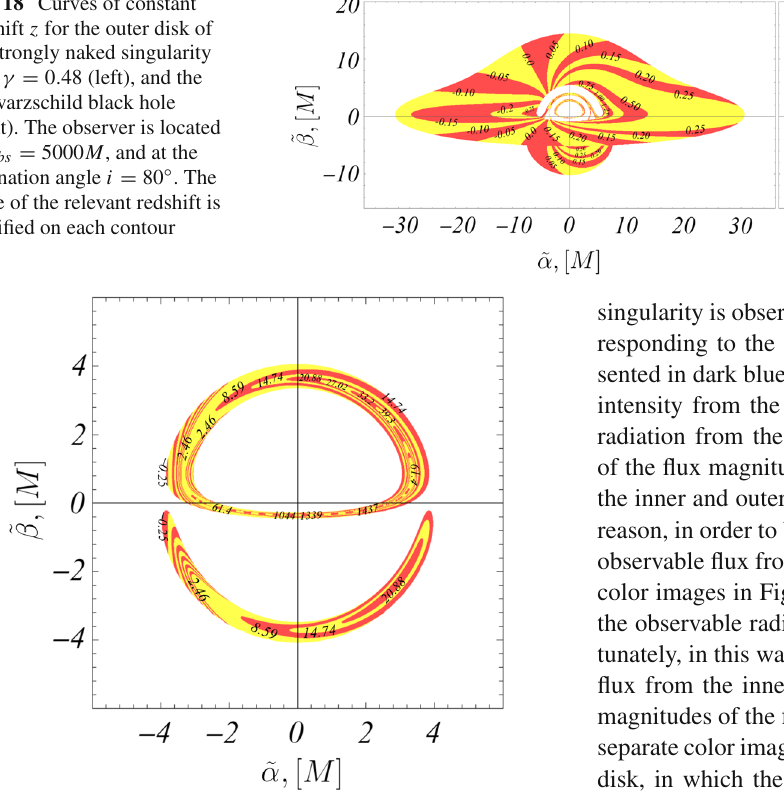
Fig. 19 Curves of constant redshift z for the inner disk of the strongly naked singularity with γ = 0 . 48. The observer is located at r obs = 5000 M , and at the inclination angle i = 80